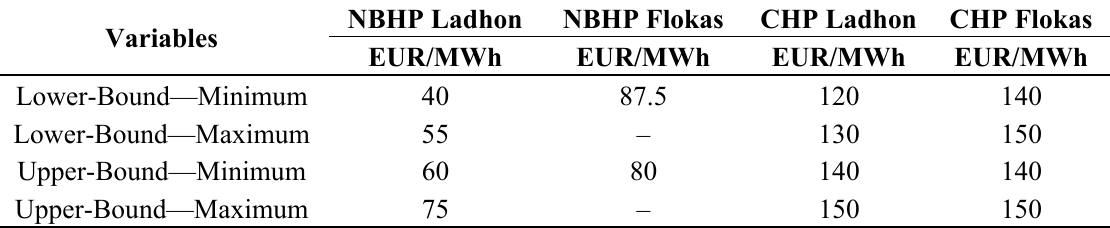
Table 4. Lower- and upper- fuzzy-boundary intervals for the unit benefit and unit penalty for hydropower production EUR/MWh at Ladhon and at Flokas.